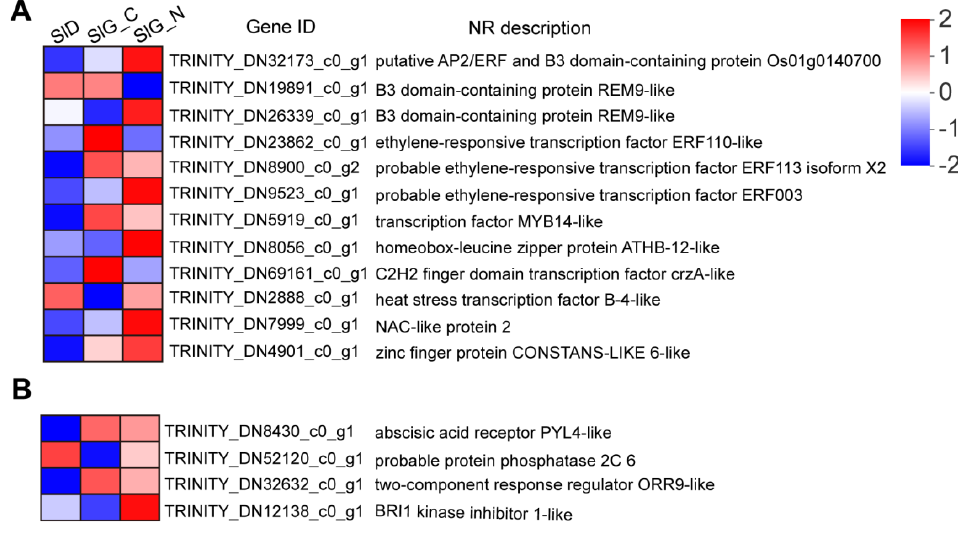
Figure 5. Heatmap of differential expression genes related to the transcriptional regulation ( A ) and hormone signal pathway ( B ) in SlD, SlG_C, and SlG_N. The values of the blue to red gradient bar indicate the log 10 fold change in expression.